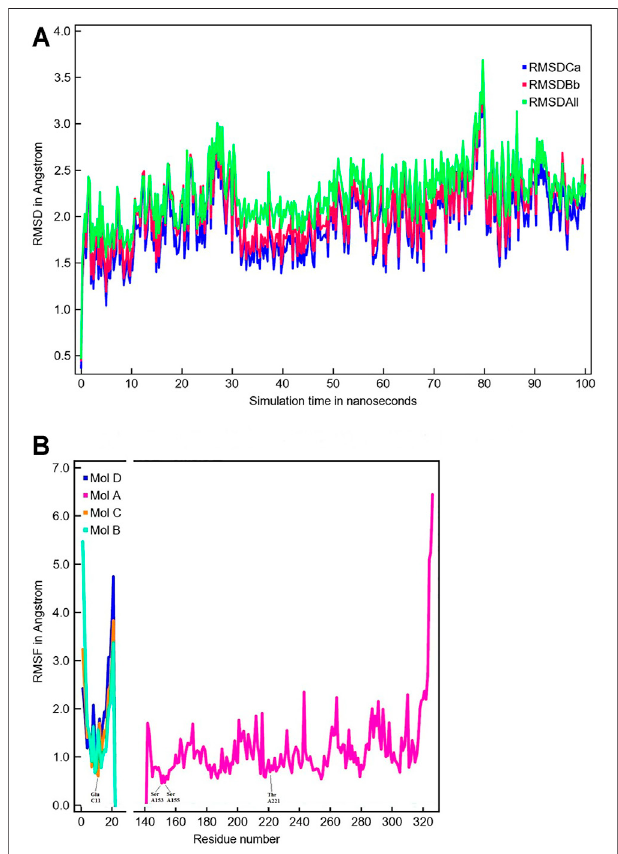
FIGURE 7 | The time evolution of the root mean square deviation (RMSD) measured from the corresponding starting structure 1DZI (Emsley et al., 2000). The different RMSD plots have the following meaning: RMSDCa (blue) is the RMSD for C-alpha, RMSDBb (red) is the RMSD for the backbone and RMSDAll (green) is the RMSD plot for all-heavy atoms (A) . The root mean square fl uctuation (RMSF) in Angstrom per solute protein residue calculated from the average RMSF of the atoms constituting the residue: integrin Mol A (magenta), collagen Mol B (cyan), collagen Mol C (orange) and collagenMolD(blue). ARMSF ofexactlyzero meansthatthatresidue number is not present in the Molecule (B) .